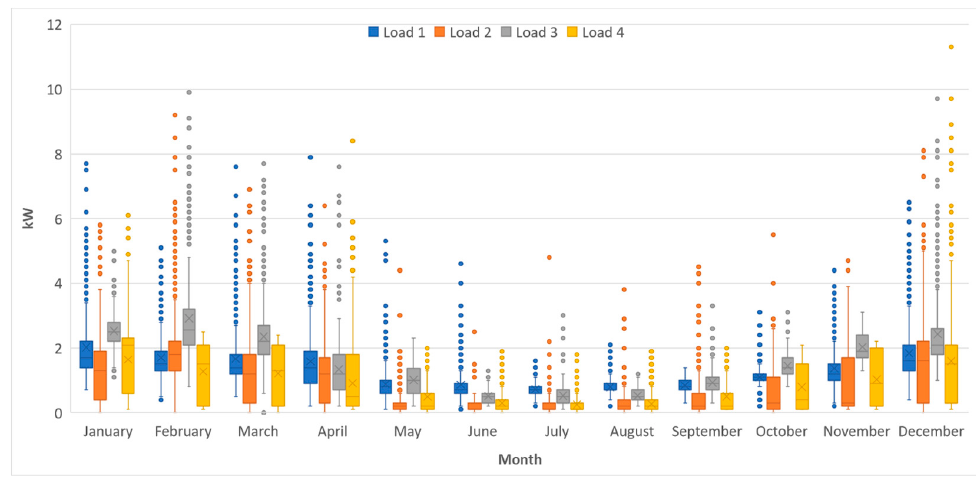
Figure 1. Annual, monthly and peak loads for four holiday homes in